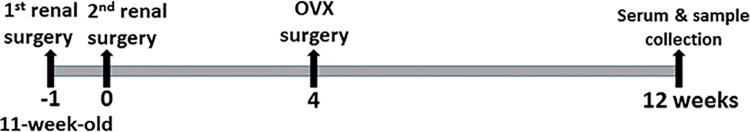
Illustration of the study workflow.